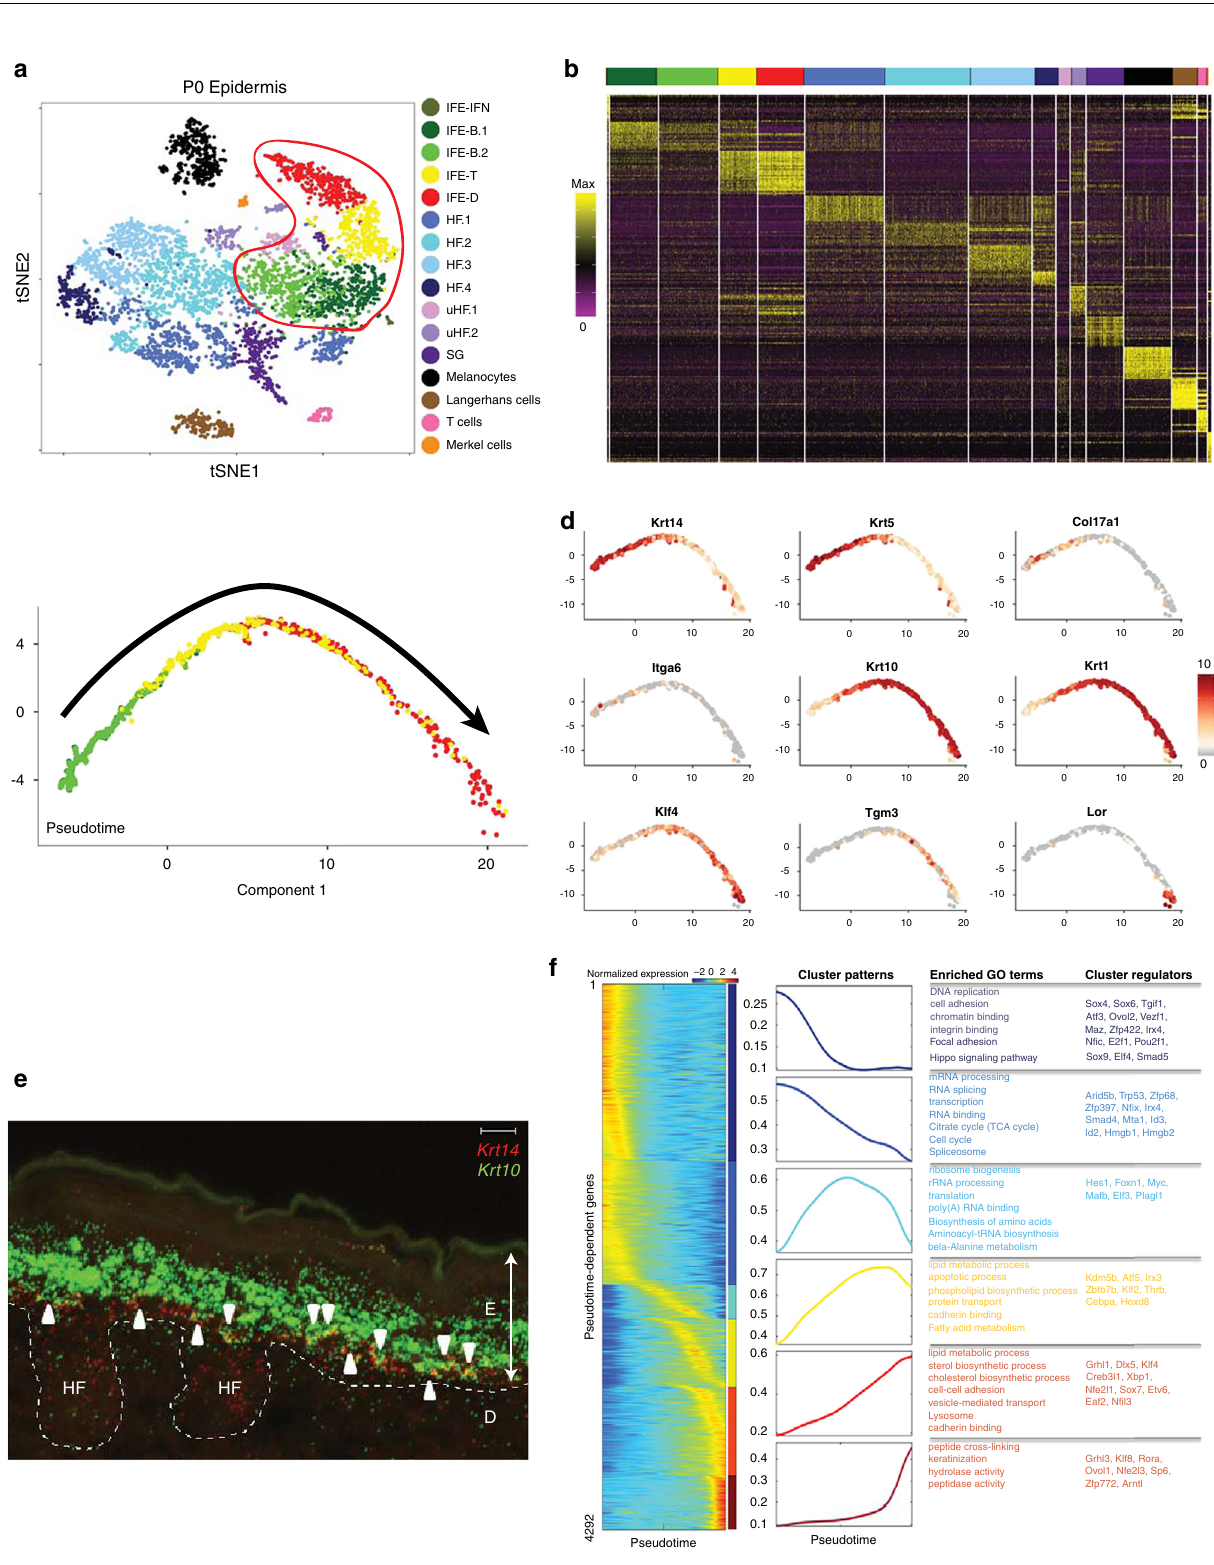
peaks in the middle of the trajectory, is enriched in genes for ribosome biogenesis and protein translation. Module 4, peaks towards the end, is enriched in lipid biosynthesis genes. Module 5, also peaks toward the end but with a slower rise, is also enriched in lipid synthesis pathways and in cell adhesion genes. Module 6, a sharp peak at the end, is enriched in crosslinking and barrier